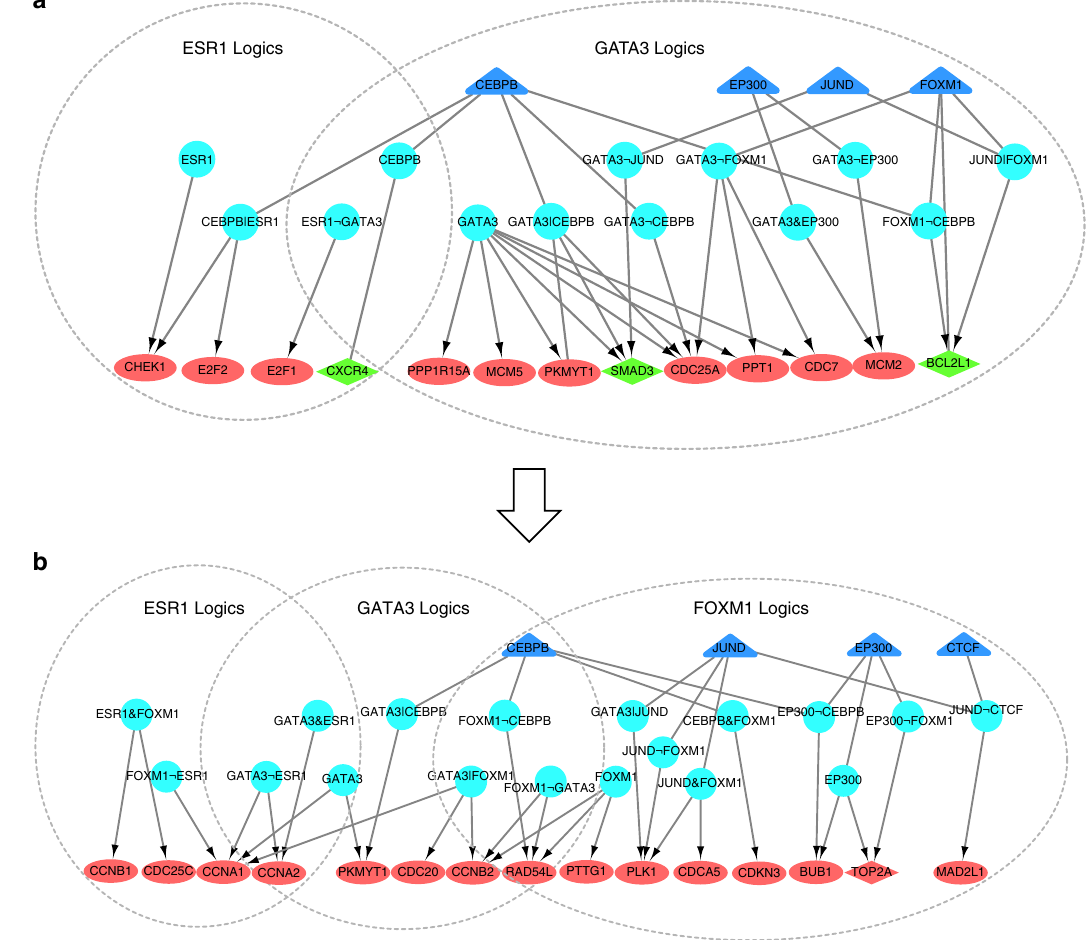
Fig. 5 E2-responsible TRNs in breast cancer. Time-course gene expression microarray data was employed. The data represents 12 time points 0, 1, 2, 4, 6, 8, 12, 16, 20, 24, 28, and 32 h (h) following the E2 treatment, which was divided into three stages, T1 (0 – 2 h), T2 (4 – 20 h), and T3 (24 – 32 h). For a (at T1-T2 stage) and b (at T2-T3 stage), triangle nodes in blue refer to TFs, and triangle nodes in light blue are TF logics. The target genes in different pathways of logics are represented in oval nodes (cell cycle: G1 to S at T1-T2 stage, G2 to M at T2-T3 stage) and diamond nodes (apoptosis). Nodes in red and green represent upregulated and downregulated genes, respectively. Logic relationships include AND (&), NOT ( ¬ ), and OR ( |